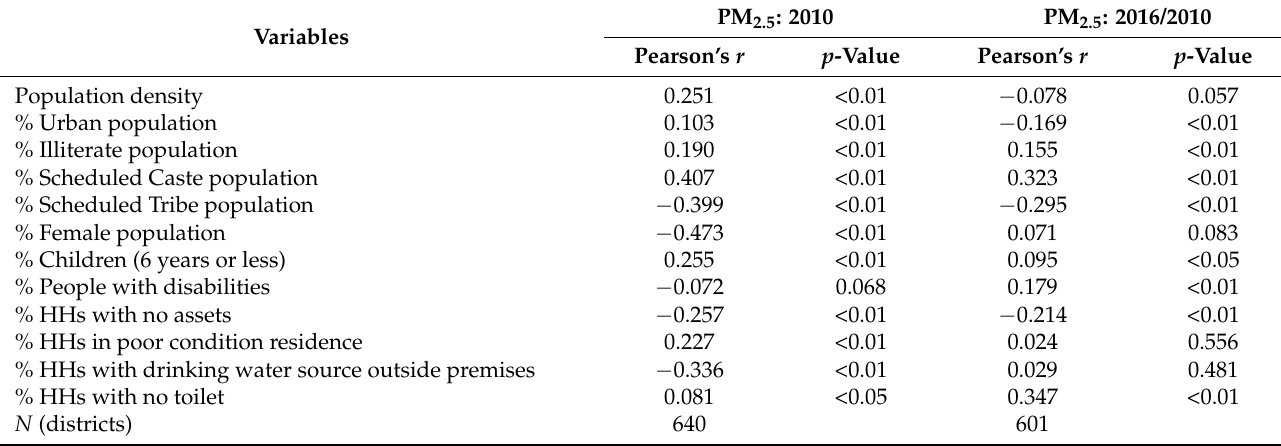
Table 3. Bivariate linear correlations of average PM 2.5 concentration (2010) and PM 2.5 concentration ratio (2016/2010) with district level